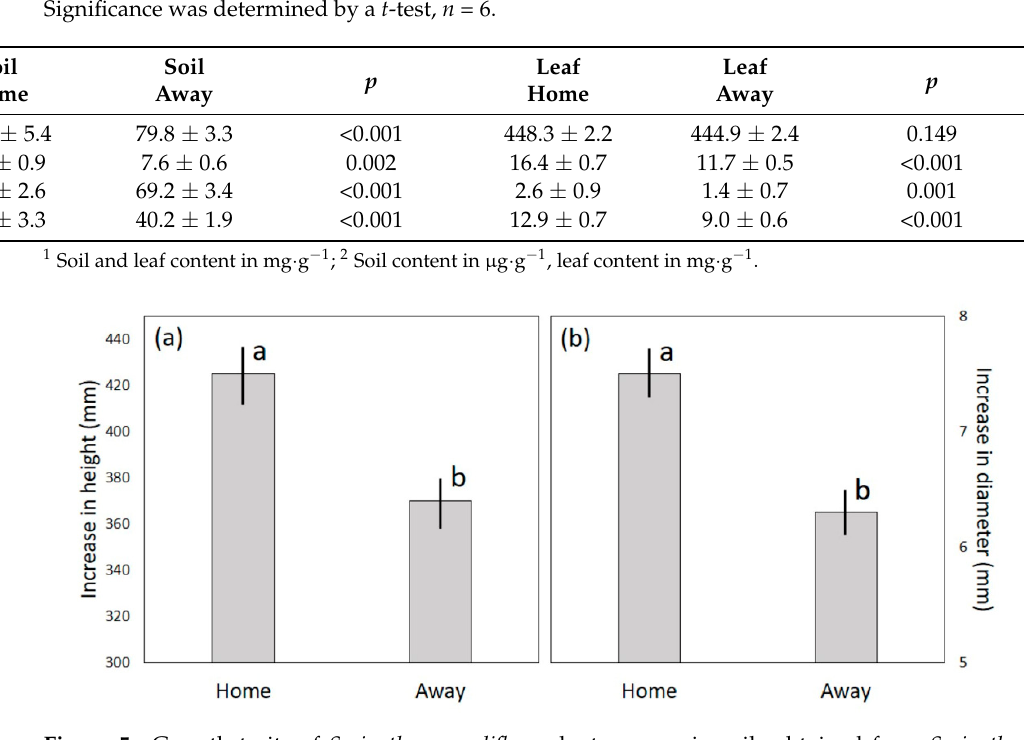
Figure 5. Growth traits of Serianthes grandiflora plants grown in soils obtained from Serianthes grandiflora rhizosphere (Home) and from soils 50–70 m away (Away). ( a ) Increase in plant height. ( b ) Increase in basal stem diameter. Mean ± SE, n = 6. Columns with different letters are significantly different, according to a t -test.